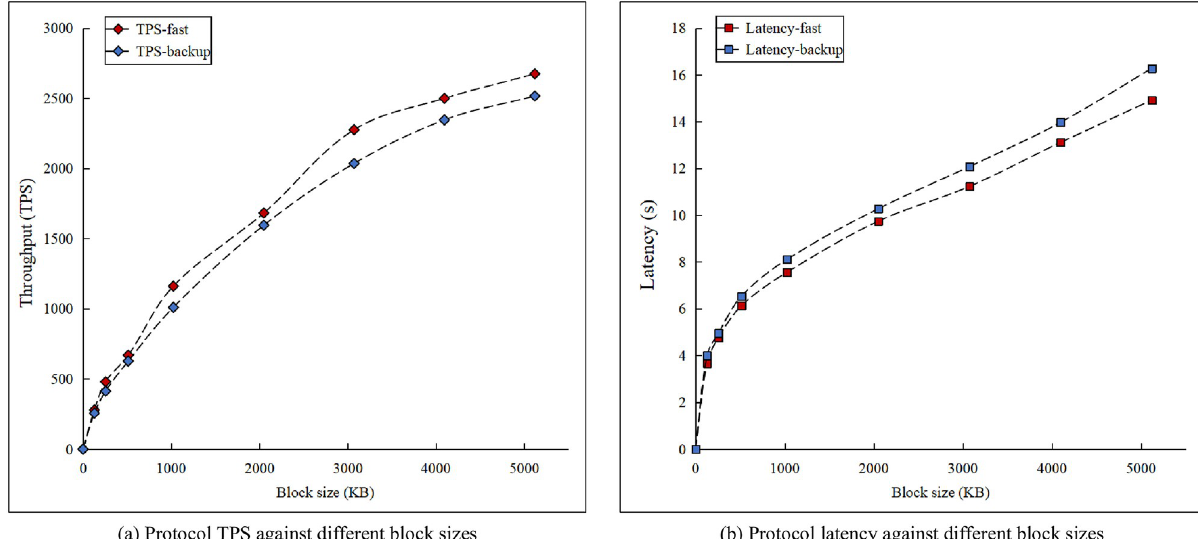
Fig 7. Protocol performance for different block